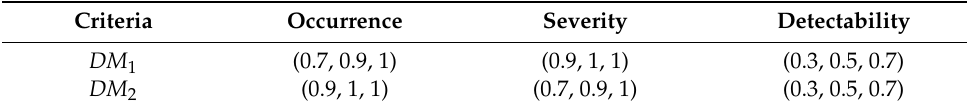
Table 19. Risk criteria judgements.